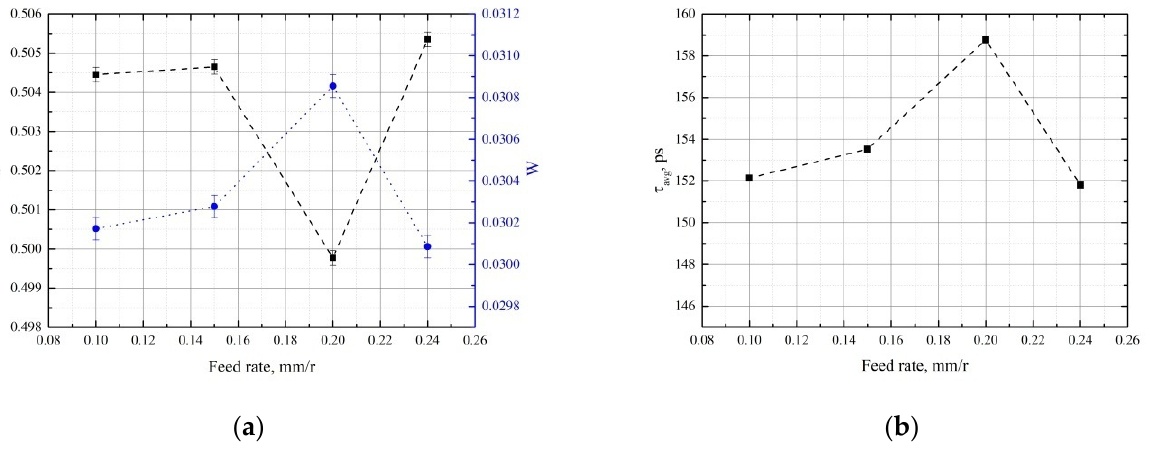
Figure 5. Dependencies of S (black) and W (blue) parameters ( a ) and average positron lifetime ( b ) as a function of feed rate for GCr15 steel.